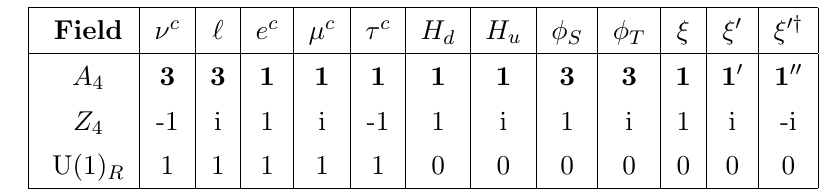
Table 3 . Transformation of the matter and (cid:13)avon super(cid:12)elds under the (cid:13)avor symmetry G f = A 4 (cid:2) Z 4 , for non trivial cases the correspondent daggered (cid:12)elds are also